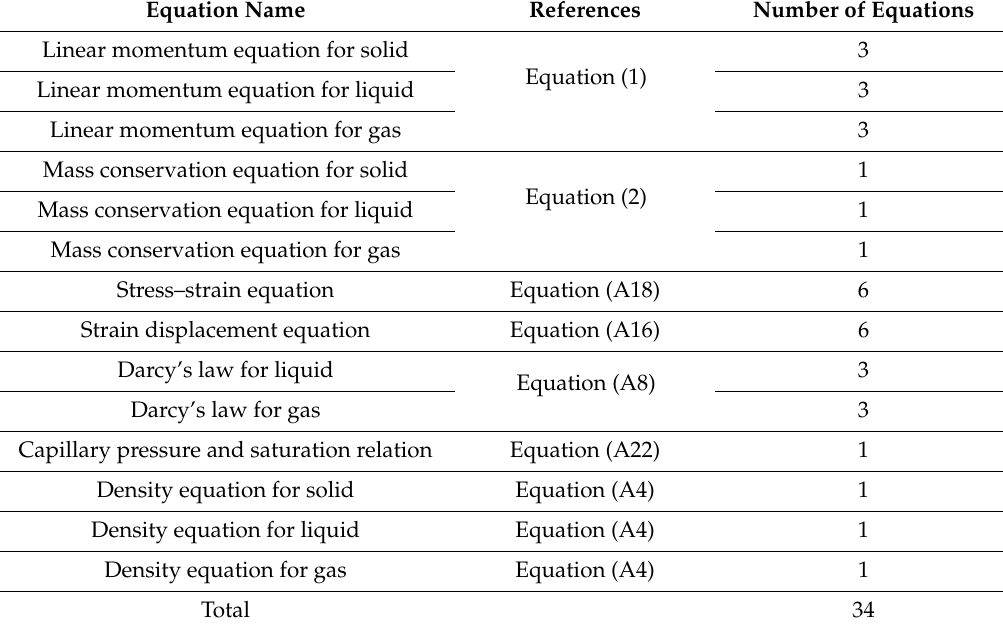
Table A1. List of